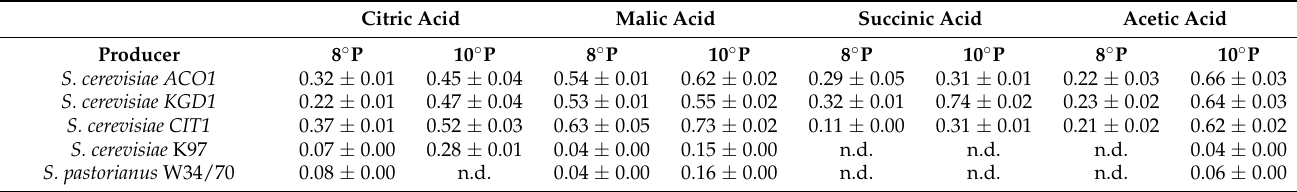
Table 3. Concentration of organic acids (g L − 1 ) in beers produced from 8 ◦ P and 10 ◦ P worts at 12 ◦ C after 7